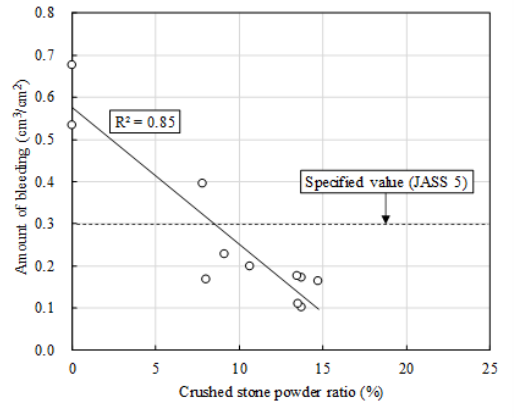
Figure 7. Relationship between surface area of crushed stone powder and unit quantity of water.